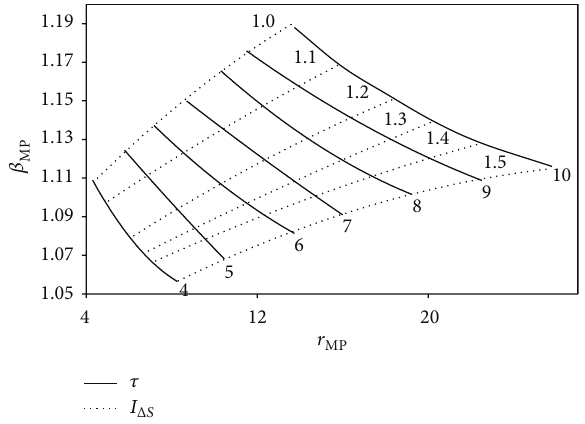
̇𝑊 circumstances based MAX